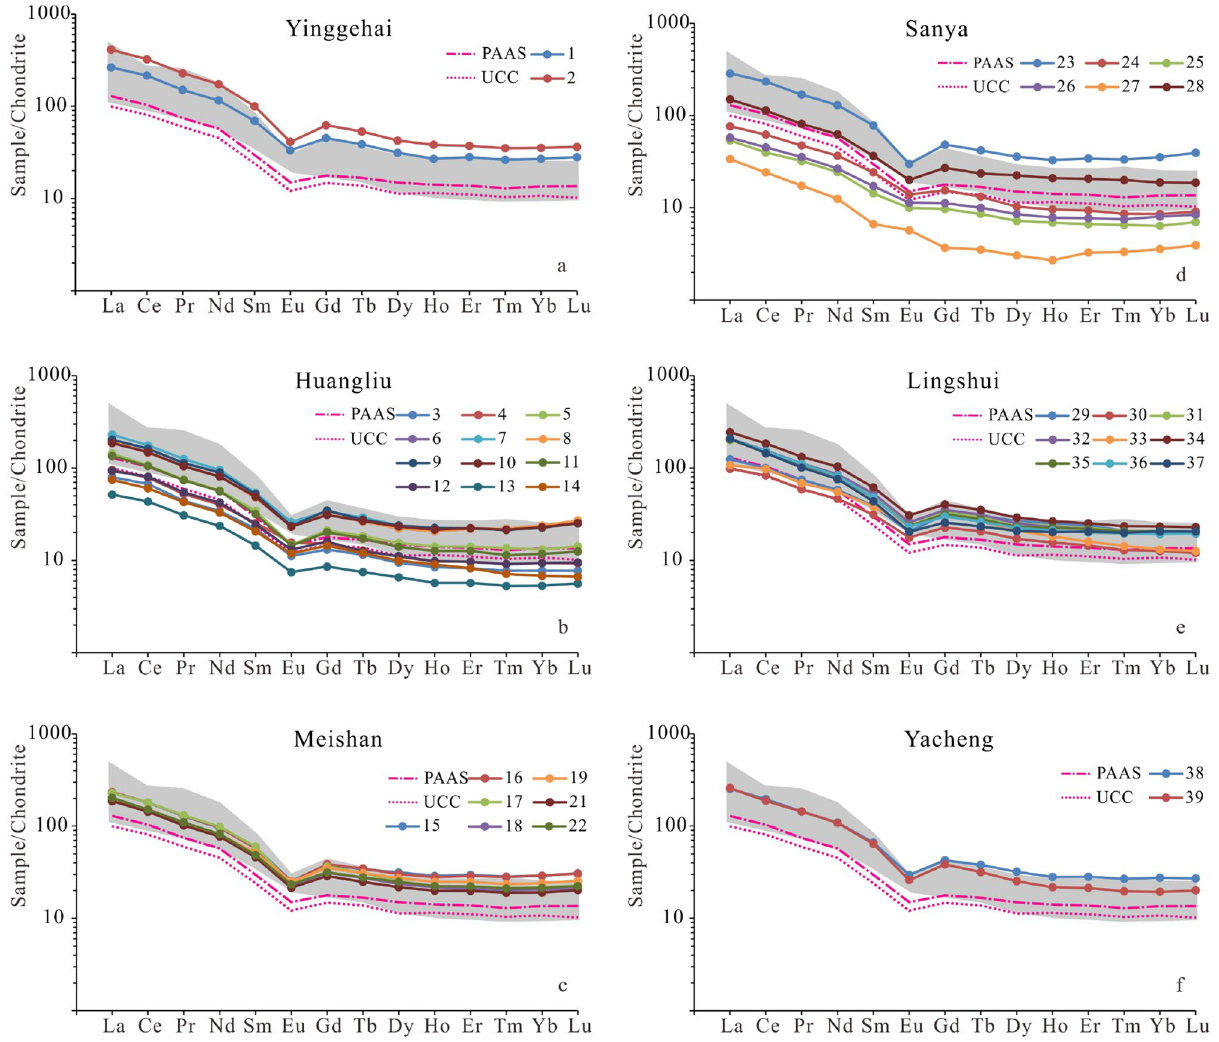
Figure 6. Chondrite 50 normalized REE concentrations in Cenozoic sediments from the junction area of Yinggehai and Qiongdongnan basins. Grey area indicates sediments likely from Hainan Island source 51